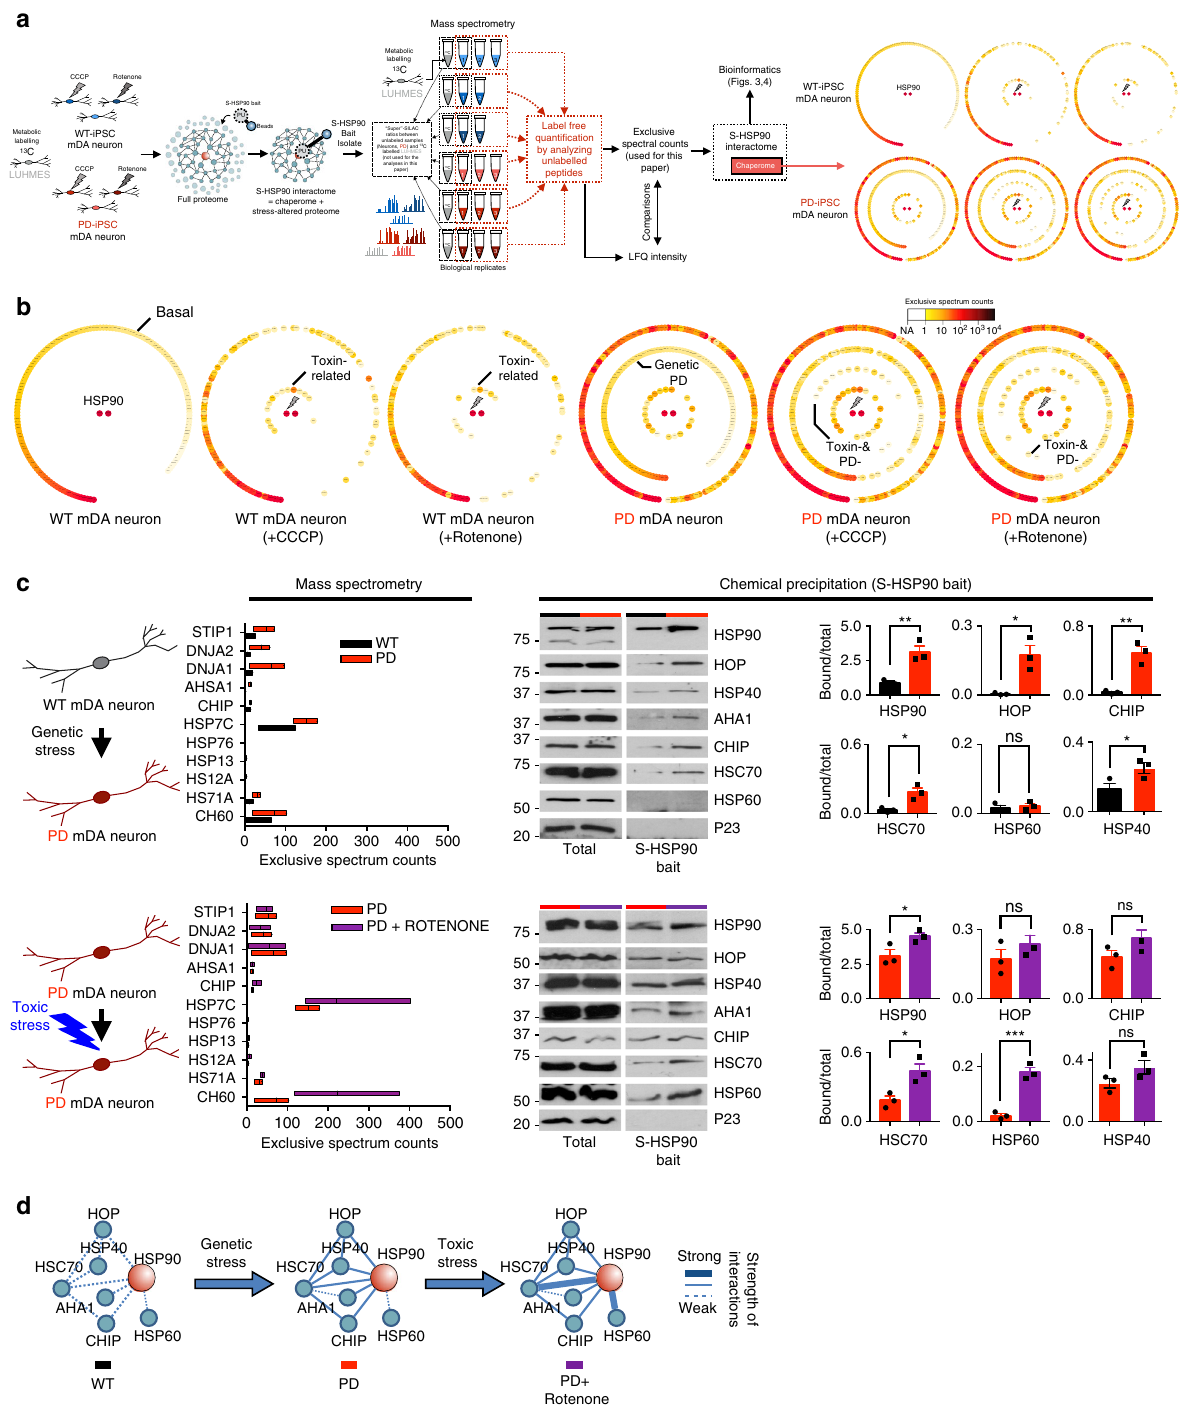
Fig. 3 Chaperome network composition under PD-relevant stresses. a Schematic illustration of the experimental design for chemoproteomic studies and the identi fi cation of chaperome complexes. b Chaperome proteins associated with S-HSP90 in each stress condition. Large circles capture the chaperome protein classes identi fi ed in human PSC-derived 65-day mDA neurons for each condition. Small yellow to red colored circles represent known chaperome proteins and their expression levels from low to high. The outermost layer of small circles represents the set of chaperome members found in unstressed WT neuron and the matched set under the various stress conditions. The three inner layers of circles represent chaperome members enriched in PD (labeled genetic, outer circle), in CCCP and rotenone (10 µ M CCCP; 20 nM rotenone; labeled toxin, middle circle) and the combination of genetic and toxic (inner circle). This is a vector graphic that can be enlarged for protein identity. c Mass spectrometry and western blot con fi rmation of S-HSP90 chaperome members under the indicated stress conditions. MS, Floating bar plot, lines inside the bars are mean; the range of the boxes corresponds to 25 and 75 percentile, n = 3 WT, n = 3 PD, n = 3 PD + rotenone, where each n is a different experiment. WB, Mean ± SEM, n = 3 individual values from the different experiments shown as points, t -test, *** p < 0.001; ** p < 0.01; * p < 0.05; ns p > 0.05. d Summary schematic showing remodeling of the chaperome